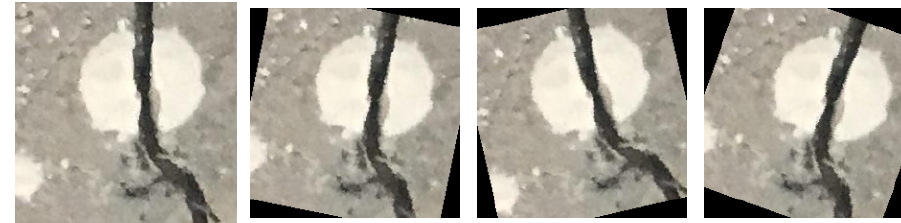
Figure 4. Example of Random Rotation transformation. (Left is the original image).